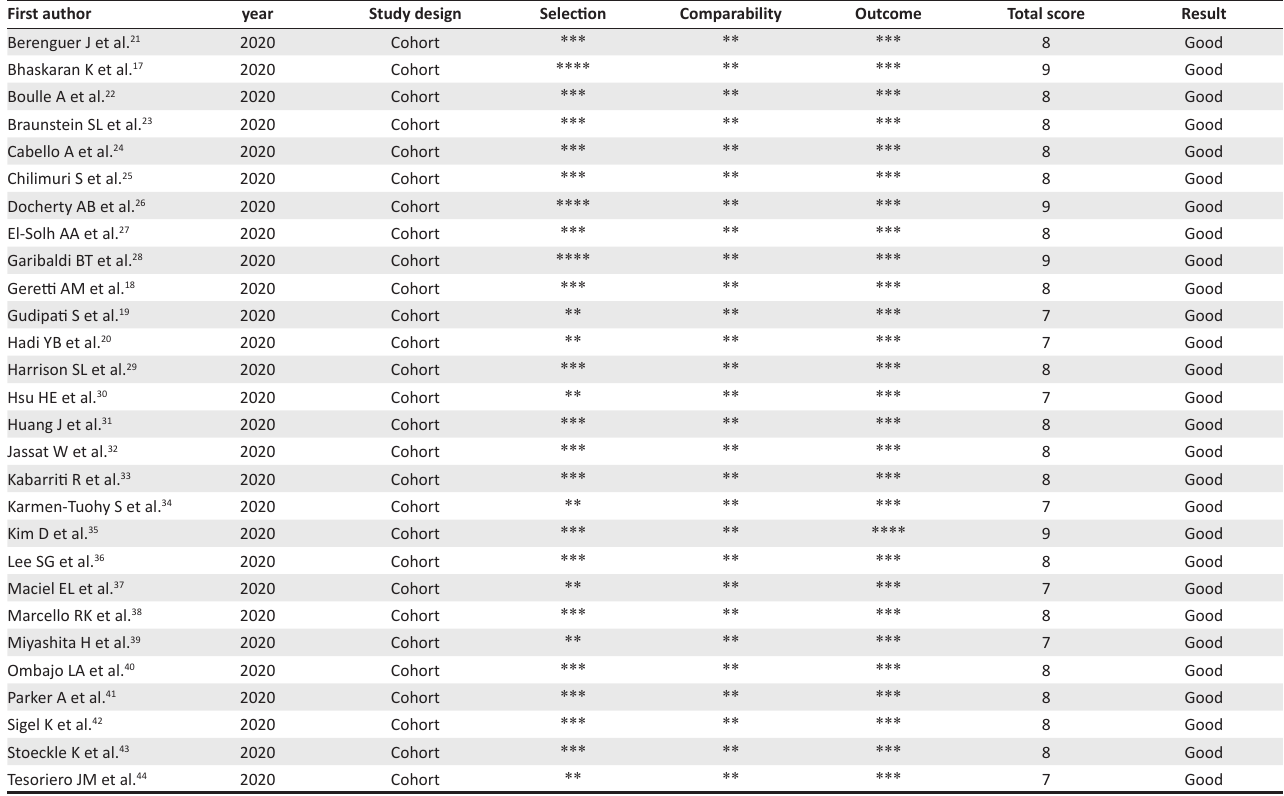
TABLE 3: Newcastle–Ottawa quality assessment of observational studies.